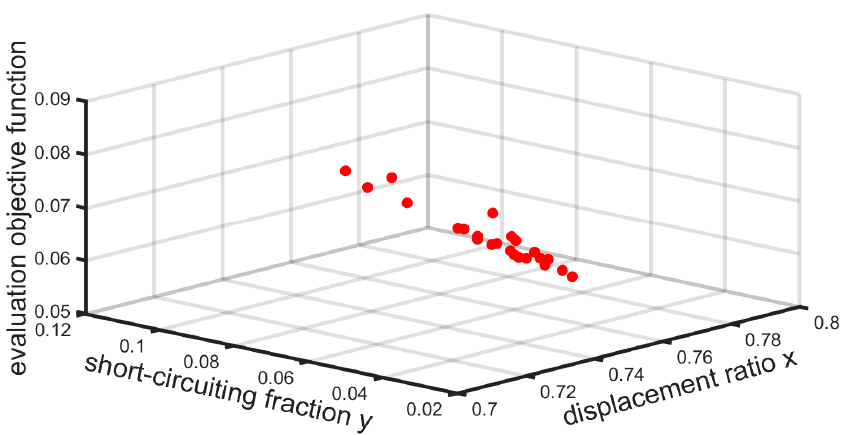
Figure 15. 3D Pareto front results of the partial load operating condition.